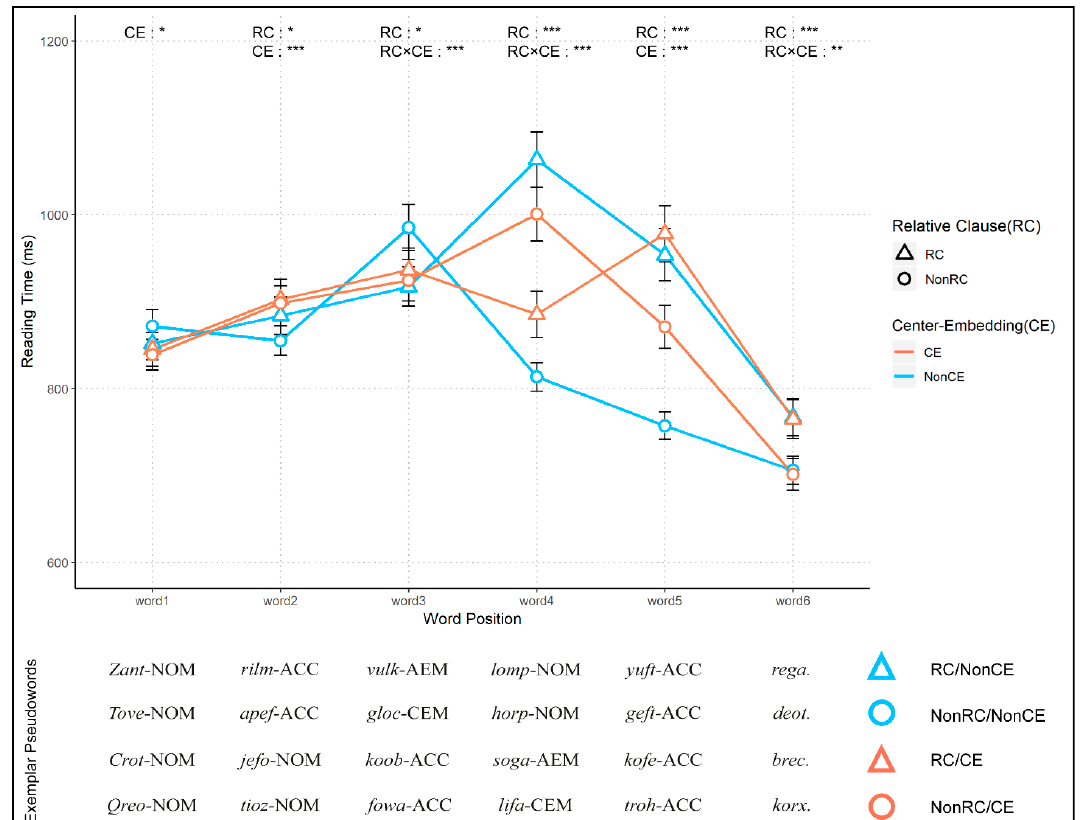
Figure 4. Reading time data from the self-paced pseudoword reading task in Experiment 2. The mean reading times with standard deviations are depicted for all the conditions from Experiment 2. The x-axis indicates the position of pseudowords presented, and the y-axis denotes the reading times in milliseconds (ms). The triangular data points depict the RC condition, while the circular data points depict the non-RC (NonRC) condition. Blue and orange lines indicate non-CE (NonCE) and CE conditions, respectively. The significant effects from two-by-two linear mixed-effect analyses were depicted at the top of each word position (for details see Table 5). Exemplar pseudowords labeled with the four conditions (i.e., RC/NonCE, NonRC/NonCE, RC/CE, NonRC/CE) are presented at the bottom. Abbreviations: RC (the main effect of relative clauses), CE (the main effect of center embedding), RC × CE (an interaction between the relative clause and center embedding), AEM (adnominalizing ending marker), CEM (conjunctive ending marker), NOM (nominative case marker), ACC (accusative case marker). (* = p < 0.05, ** = p < 0.01, *** = p < 0.001).